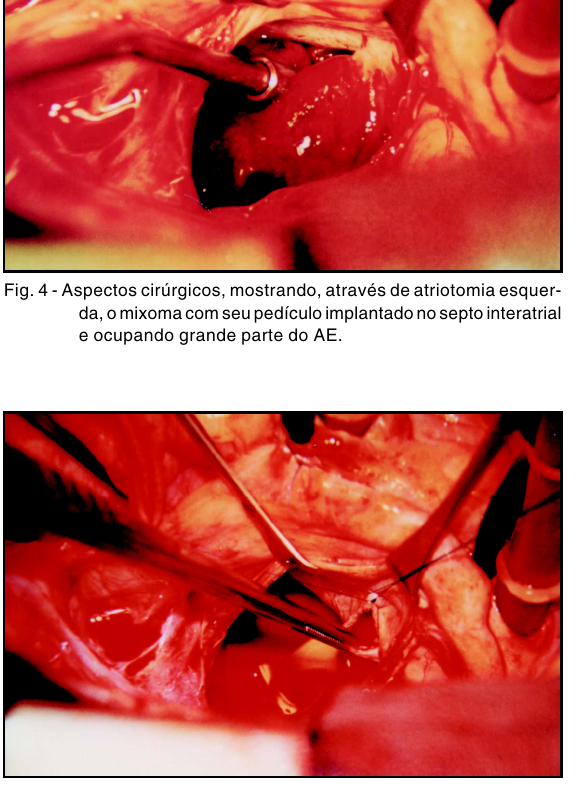
Fig. 5 - Aspectos cirúrgicos, mostrando ressecção de parte do septo interatrial com o mixoma, proporcionando margem de segu- rança para se prevenir a recidiva.